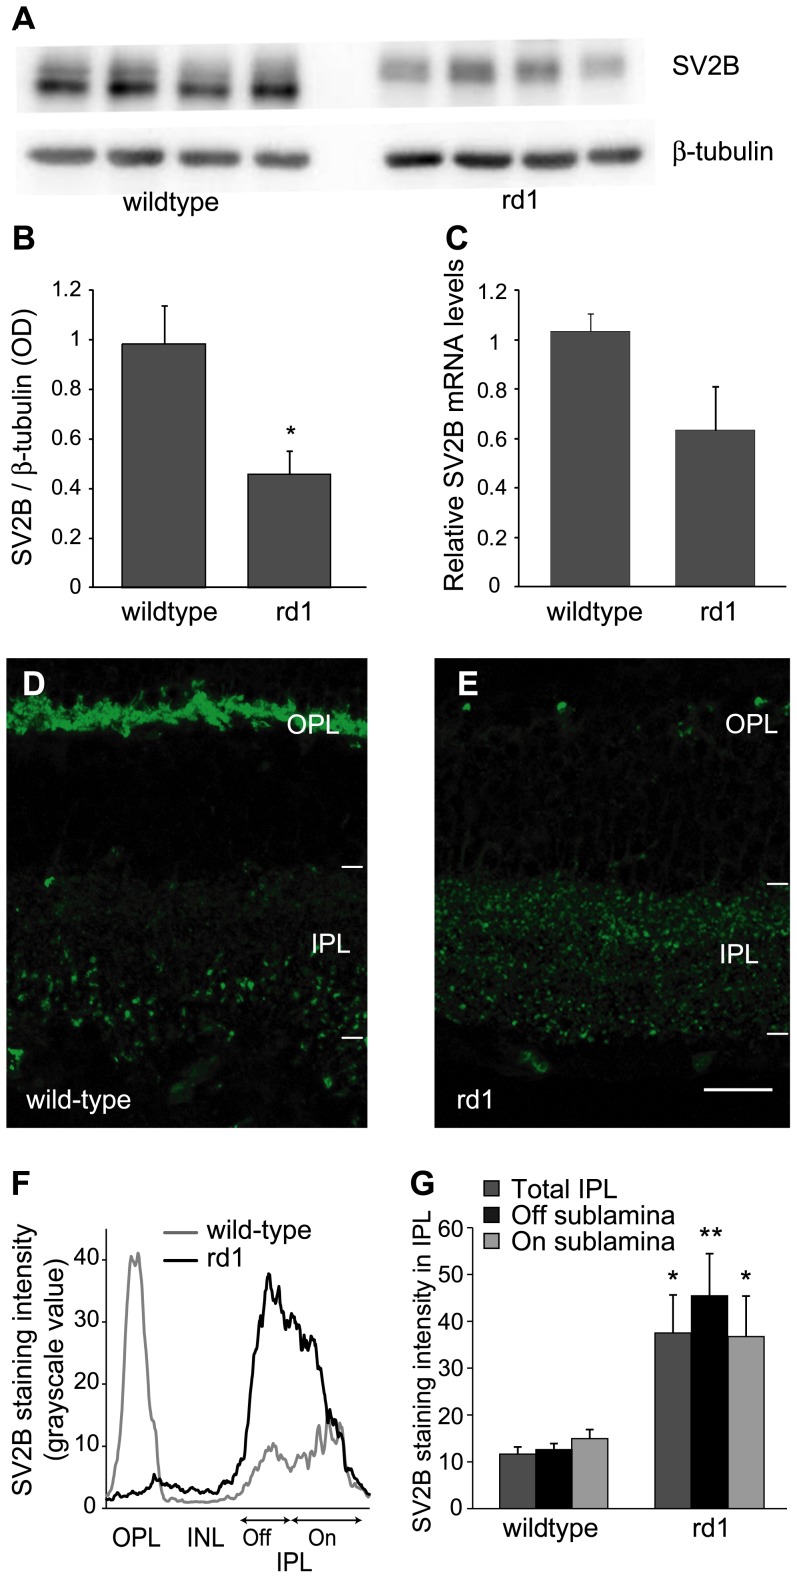
Ribbon-specific protein SV2B was downregulated in retina, but upregulated in IPL of rd1 mouse.A) Representative blots of SV2B and β-tubulin in adult wild-type and rd1 mouse retinas. Each band is from a different animal. B) Ratio of SV2B to β-tubulin (mean ± SE) in adult rd1 mouse retina was significantly lower than in wild-type mouse (p = 0.01; n = 5). C) Relative mRNA levels (mean ± SE) of SV2B in adult rd1 mouse were approximately 40% lower than in wild-type, although the difference was not statistically significant (p = 0.062; n = 6). D, E) Representative images of retinal sections of adult wild-type (D) and rd1 (E) mouse retinas immunostained for SV2B. Scale bar: 50 µm. A) Intensity profile of SV2B through retinal depth of the images shown in D and E. Similar to synaptophysin (Figs. 2A, 2B, 2C), SV2B is nearly absent in OPL of rd1 mouse retina, whereas that in IPL is higher than in wild-type, particularly in the Off sublamina. B) Levels of SV2B (mean ± SE), measured with quantitative immunohistochemistry were more than twofold higher in IPL of adult rd1 mouse retina than in wild-type (p = 0.014; n = 5). The SV2B levels were higher in both On and Off sublaminas of IPL, although the increase was more pronounced in the Off sublamina (On: p = 0.031; Off: p = 0.005). *p<0.05; **p<0.01.